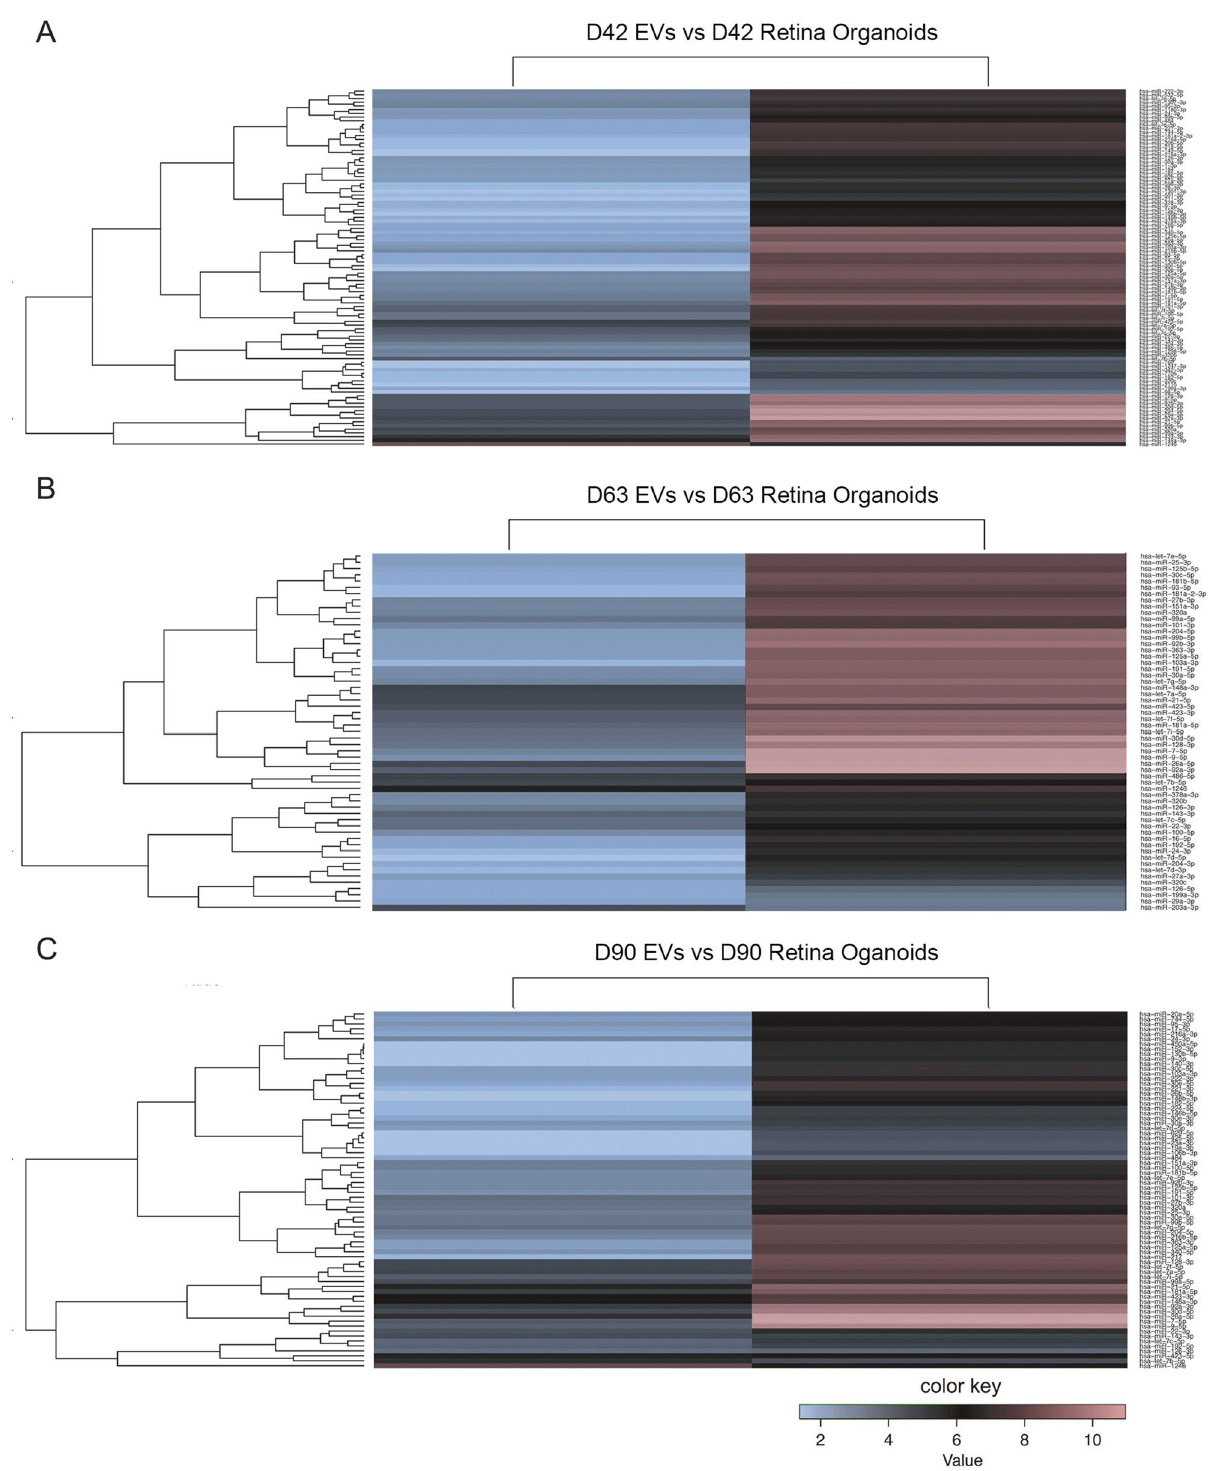
Figure 4. Comparative NGS Hierarchical cluster analysis of small noncoding RNA contained in hiPSC- derived 3D retinal organoids and released EVs. Each heat map shows a clear separation of differential miRNA profile between hiPSC-derived 3D retinal organoids and corresponding isolated EVs at ( A ) D42, ( B ) D63 and ( C ) D90. A greater number of miRNA species exhibited higher expression in 3D retinal organoid tissue compared to EVs at each time